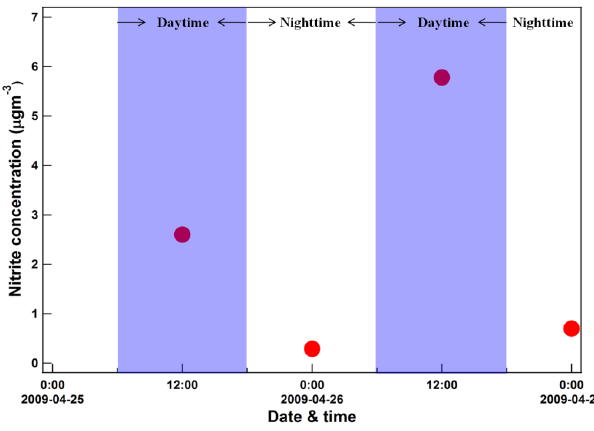
Fig. 8. Nitrite concentrations in total suspended particulates collected during the dust event on April 24-26 at Mt. Heng.